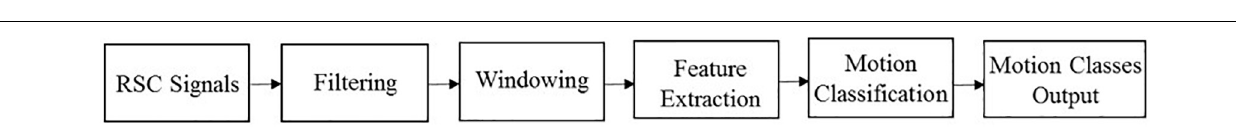
FIGURE 2 | (A) positions of sensor placement, (B) motion classes involved in this study.